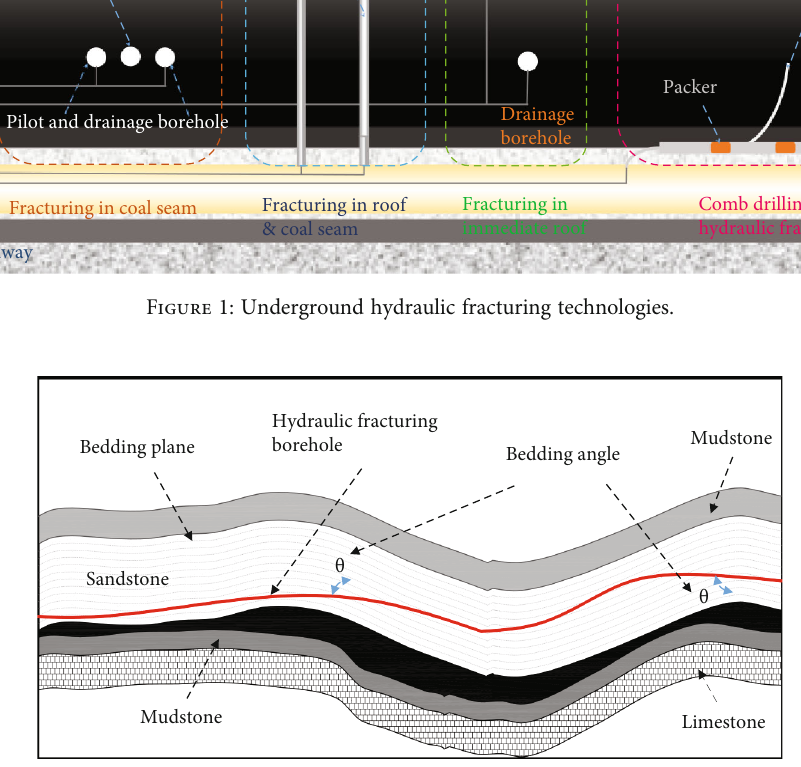
Figure 2: Schematic diagram of hydraulic fracturing long borehole in sandstone. Table 1: Mechanical parameters of the sandstone